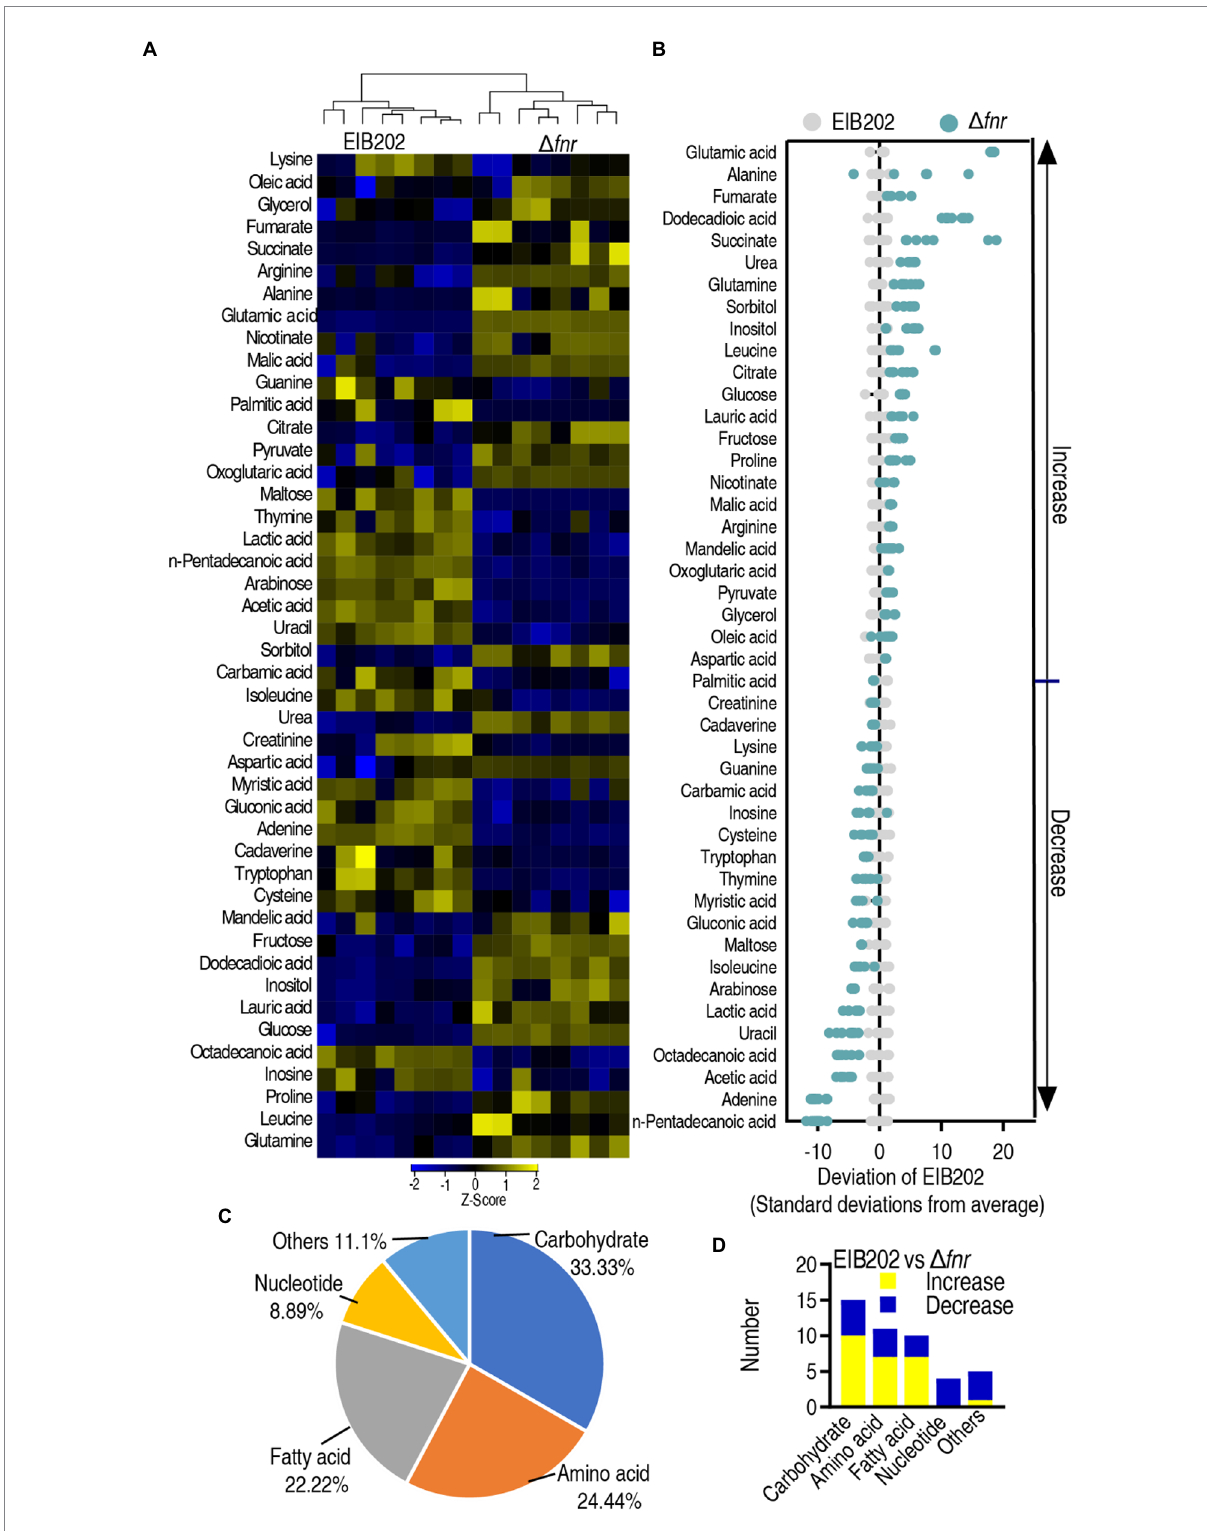
FIGURE 2 Differential abundance of metabolites in EIB202 and Δ fnr . (A) Heat map showing relative abundance of different metabolites (row). Heat map scale (blue to yellow, low to high abundance) is shown below data. (B) Z score plots of differential abundances of metabolites based on control. Data from tested groups are separately scaled to the mean and standard deviation of the control (EIB202). Each point represents one metabolite in one technical repeat and is colored by sample type (gray, control; green, Δ fnr ). (C) Category of detected different metabolites in Δ fnr . (D) The number of changed metabolites in each category of Δ fnr and